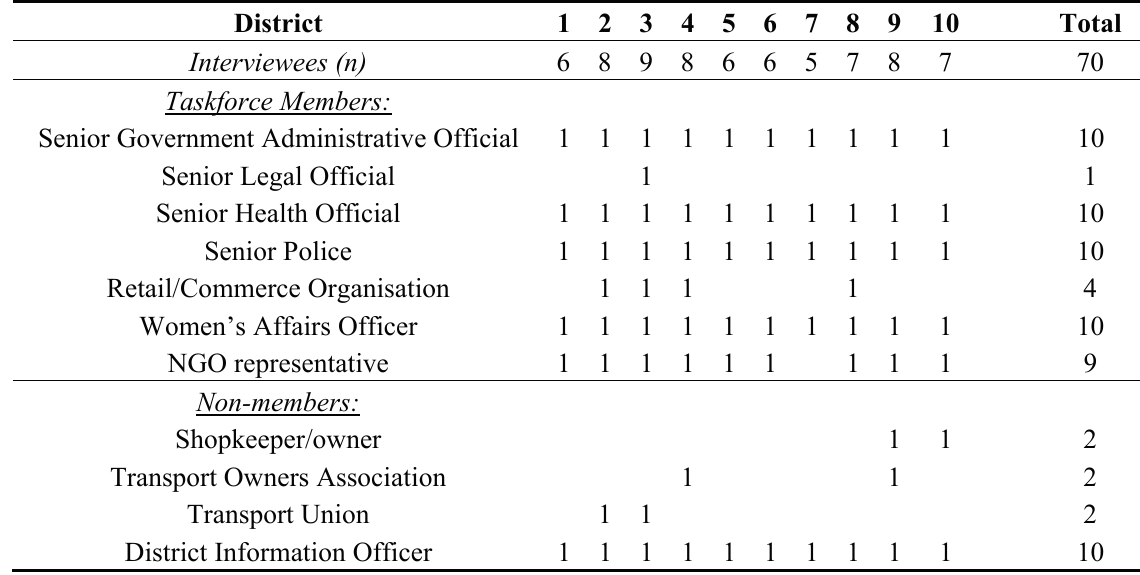
Table 1. Profile of interviewees by district and